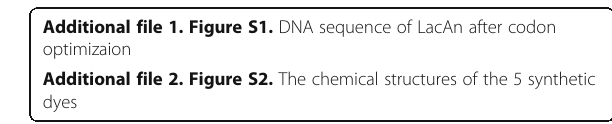
Additional file 1. Figure S1. DNA sequence of LacAn after codon optimizaion Additional file 2. Figure S2. The chemical structures of the 5 synthetic dyes